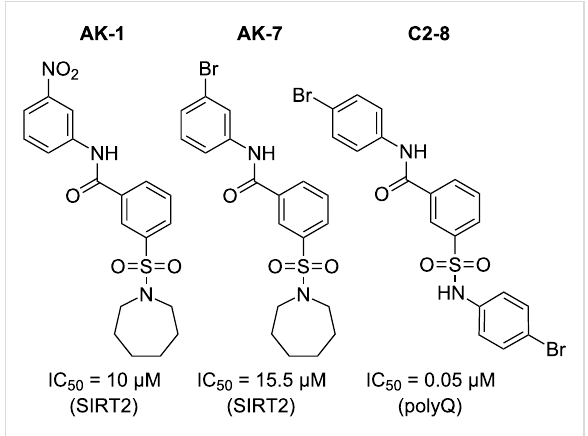
Figure 1: m -Sulfamoylbenzamides as Sirtuin 2 inhibitors (SIRT2) or suppressor of polyglutamine aggregation